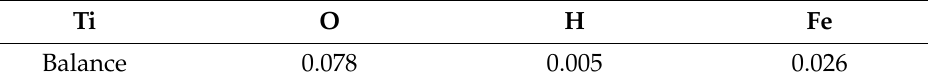
Table 1. Chemical composition (in wt%) of the CP Ti.